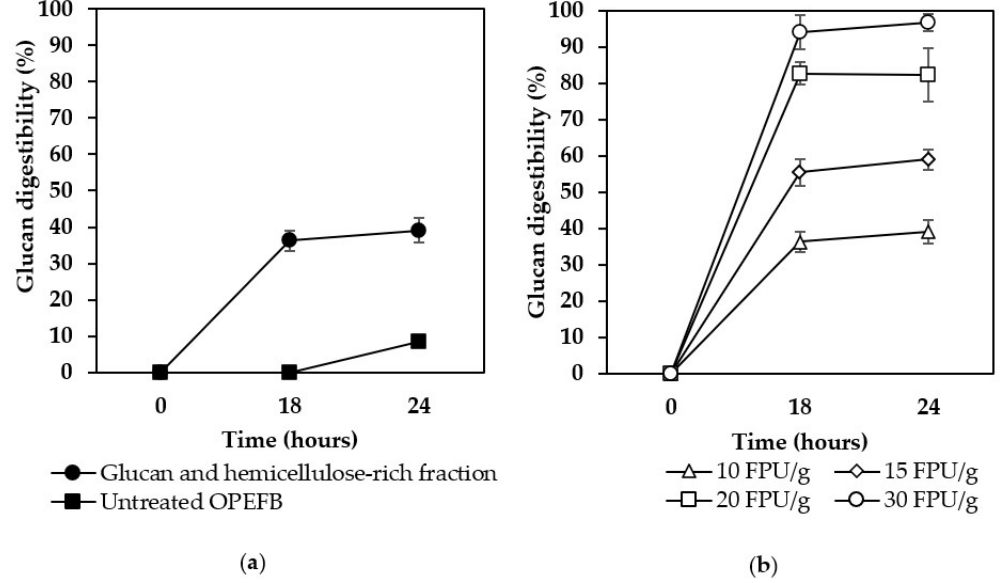
Figure 6. Glucan digestibility of ( a ) untreated OPEFB and of a mixture of evaporated glucan-rich and hemicellulosic compounds-rich fractions at enzyme loading of 10 FPU / g glucan and ( b ) a mixture of evaporated glucan-rich and hemicellulosic compounds-rich fractions using di ff erent enzyme loadings. Error bars represent ± 2 × the standard deviation.